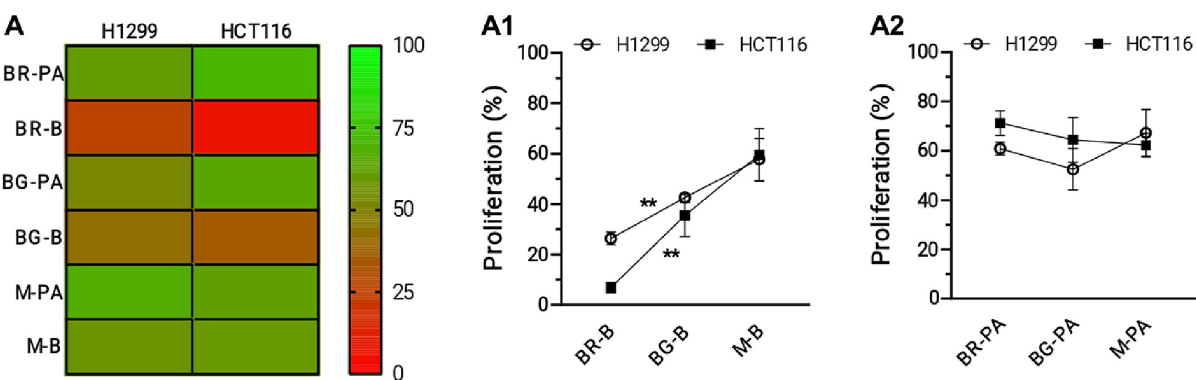
Fig 5. Anticancer effects of different extracts from pomegranate immature and ripe fruits. A) Heatmap of proliferation in H1299 and HCT116 cells exposed for 48 h to 100 μ g/mL of the indicated pomegranate fruit extracts. Data (left) and color scale (right) reflects % of respective controls treated with the vehicle DMSO. A1) Trend analysis of anticancer effects by pomegranate peel extracts shown in A. �� , p � 0.01. A2) Trend analysis of anticancer effects by pomegranate mesocarp/arils extracts shown in A.